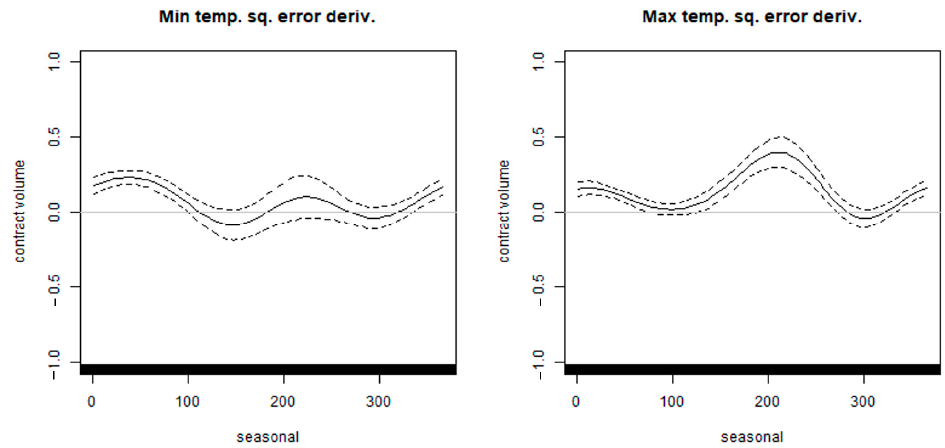
Figure 6. Estimated contract volume of the temperature squared error derivatives in the product model (13).